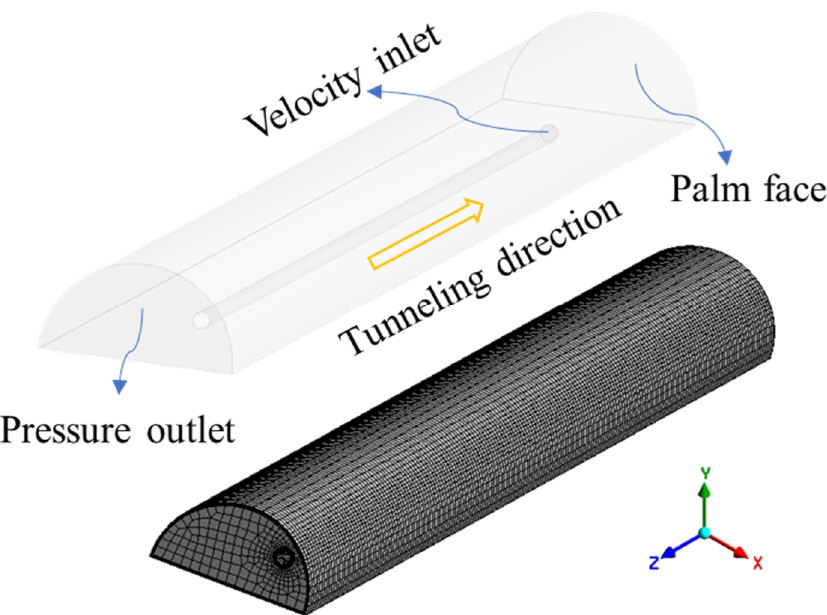
Figure 1. Tunnel geometry model and meshing.